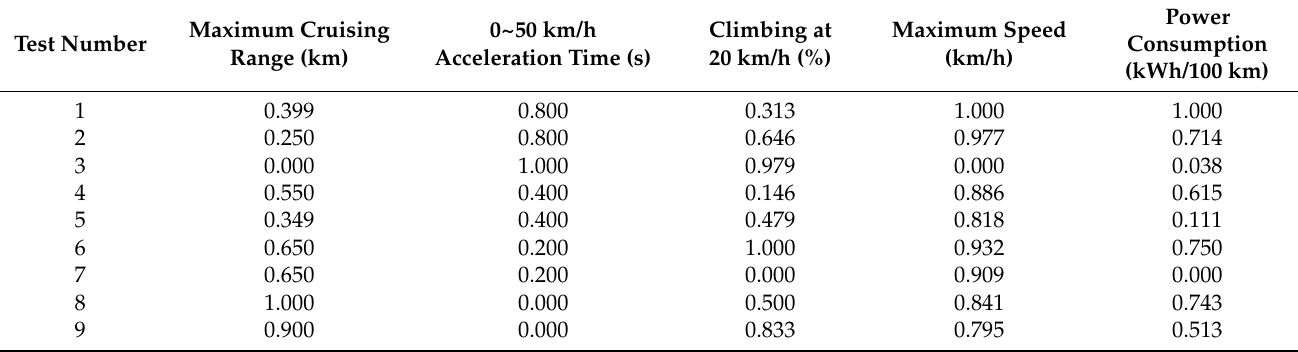
Table 12. Membership degree calculation